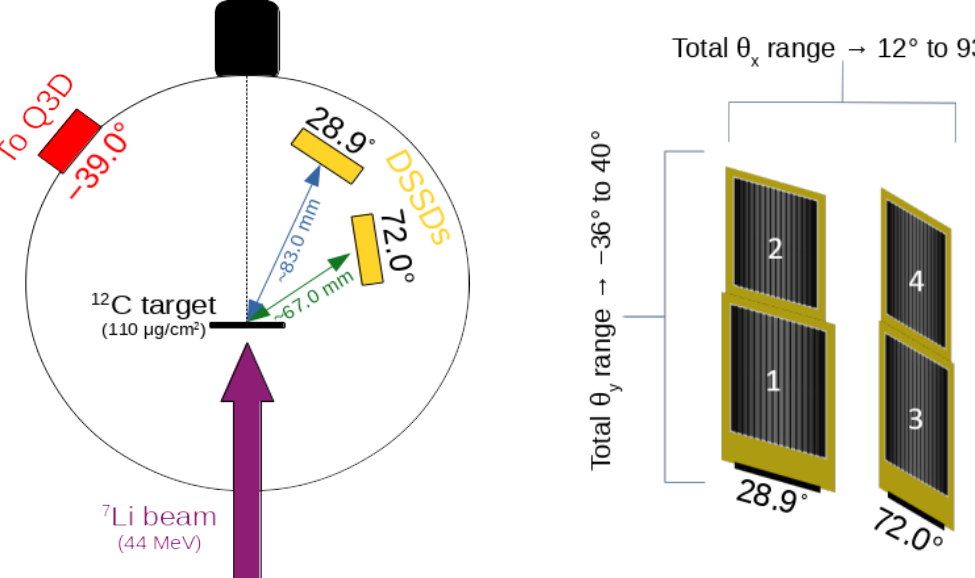
Figure 1: A diagram depicting the experimental set-up used in the chamber, showing the positions of the Q3D magnetic spectrograph and DSSD array (left). The arrange- ment of the constituent DSSDs in the Birmingham DSSD array, as well as the total angular coverage, is also shown (right) [ 11,12 ]